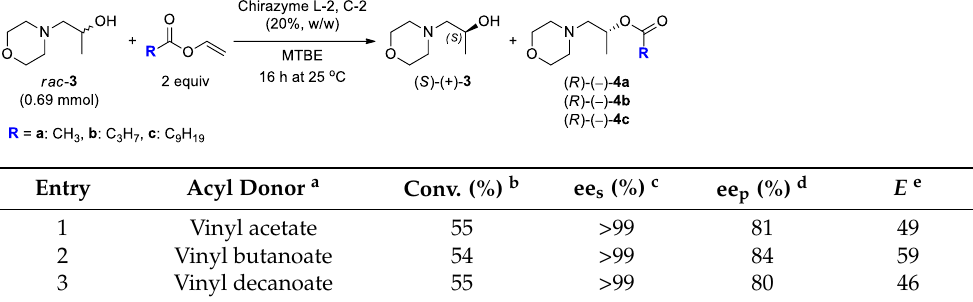
Table 3. The influence of acyl donor on Chirazyme L-2, C-2-catalyzed enantioselective transesterification of rac - 3 in MTBE after 16 h.